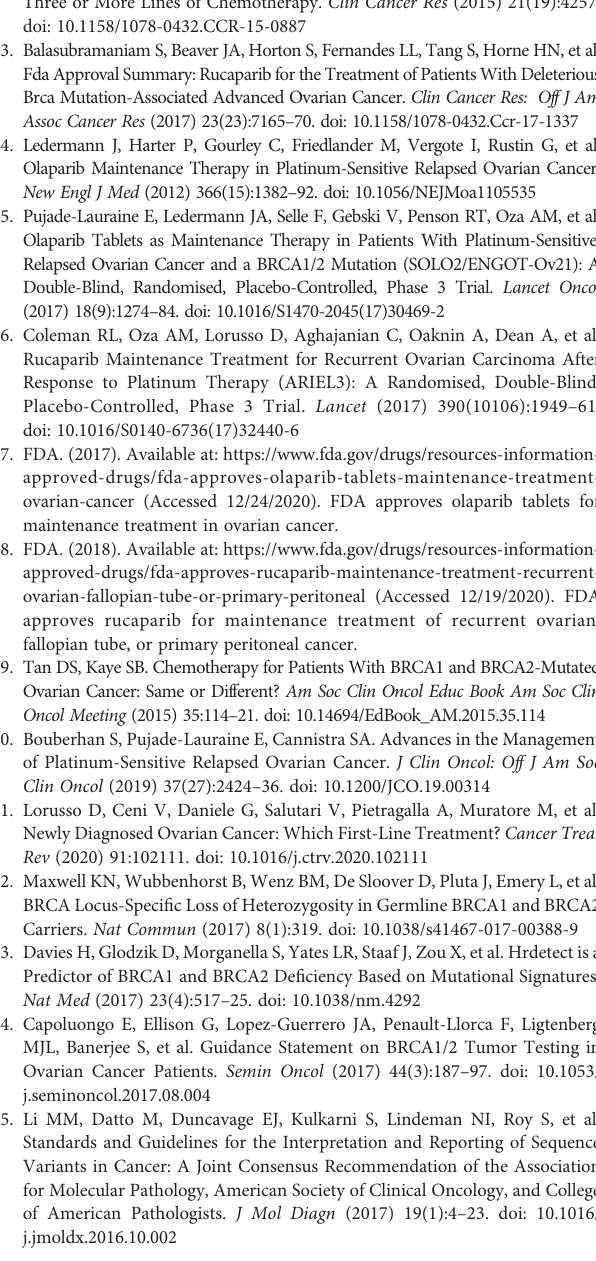
Supplementary Figure 1 | (A) Overall survival based on the presence of HRR and/or TP53 pathogenic variants in the entire cohort including patients with wild- type tumors or with pathogenic variants in other genes (excluding mucinous tumors). (B) Progression-free survival based on the presence of HRR and/or TP53 pathogenic variants in the entire cohort of fi rst-line treated patients including those with wild-type tumors or with pathogenic variants in other genes (excluding mucinous tumors). (C) Overall survival based on the presence of clonal HRR and/or TP53 pathogenic variants in the entire cohort including patients with wild-type tumors or with pathogenic variants in other genes (excluding mucinous tumors). (D) Progression-free survival based on the presence of clonal HRR and/or